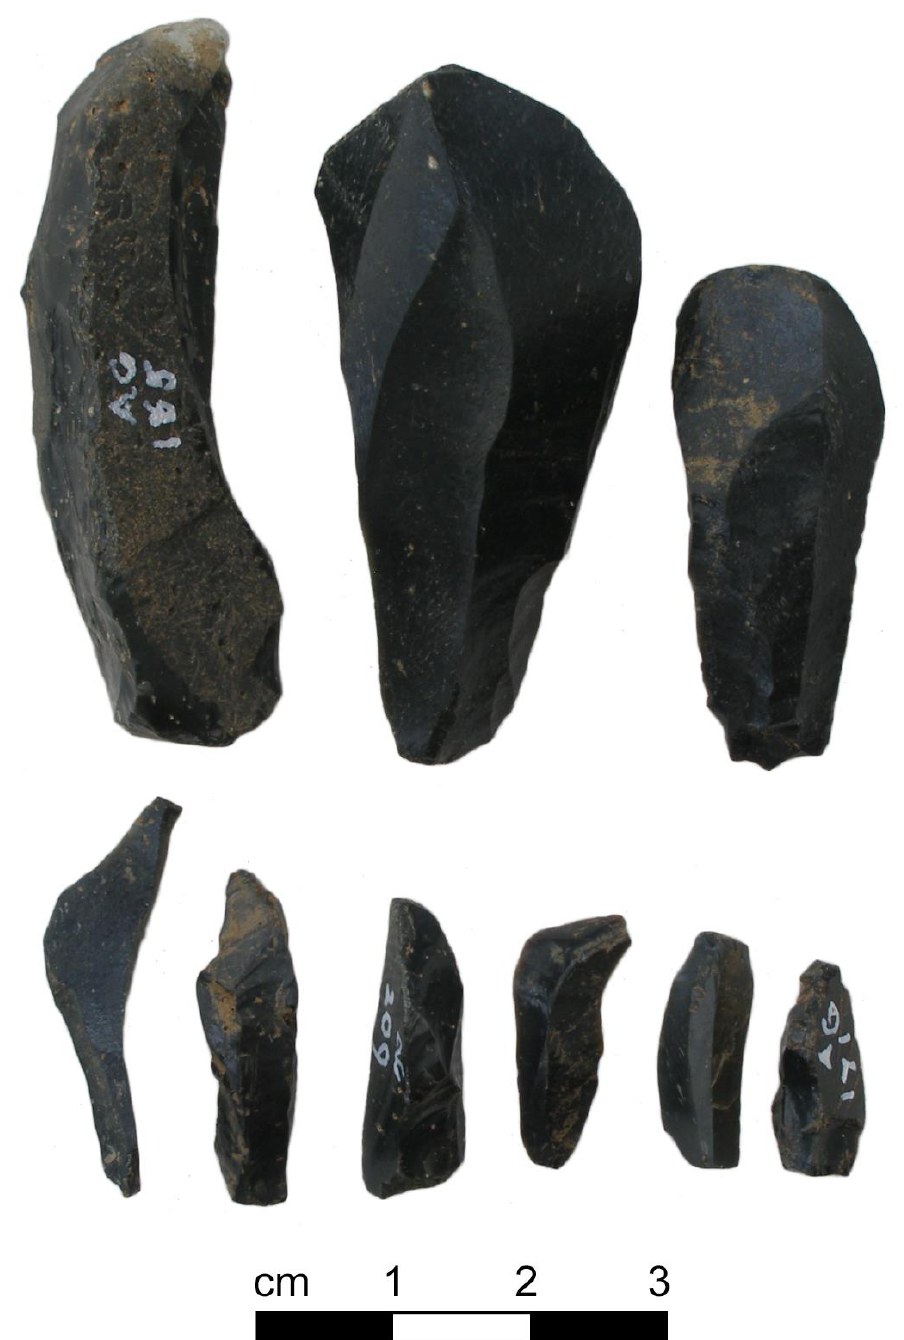
Figure 1. Pitchstone blades and microblades from Auchategan, Argyll & Bute (Marshall 1978; Ballin 2006) (photo by Beverley Ballin